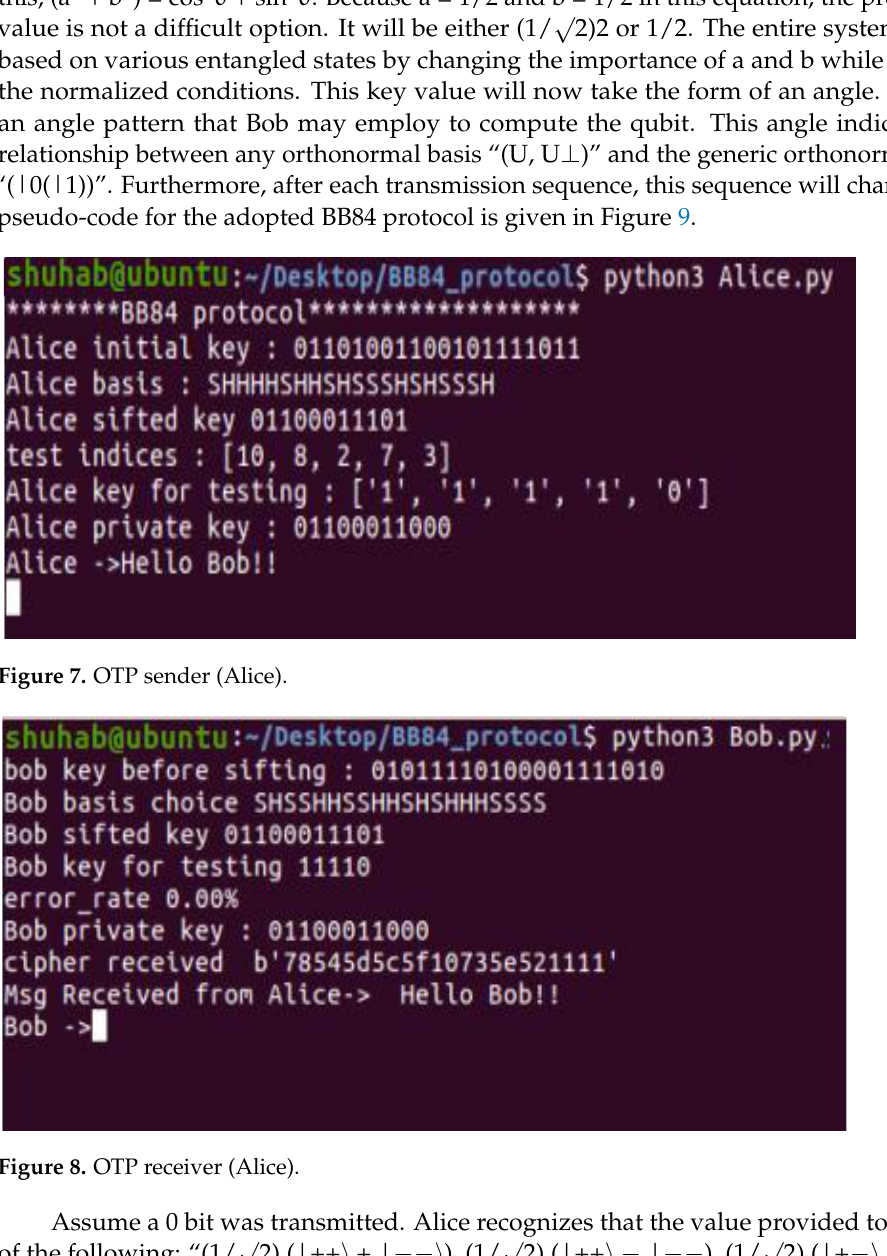
Figure 6. Testing of error rate in presence of Eve.